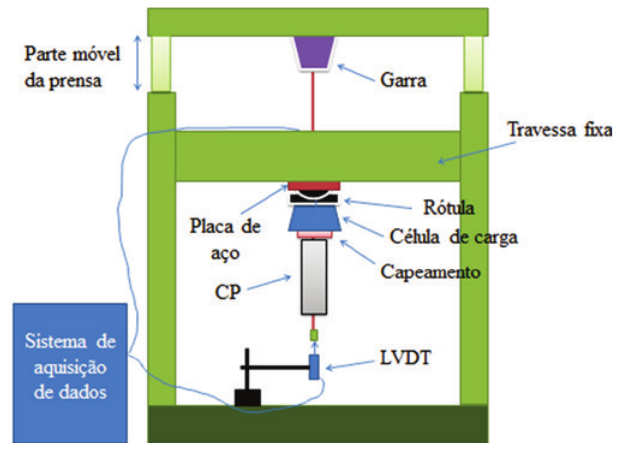
Nota: croqui sem Figura 5 Sistema de arrancamento (elevação)